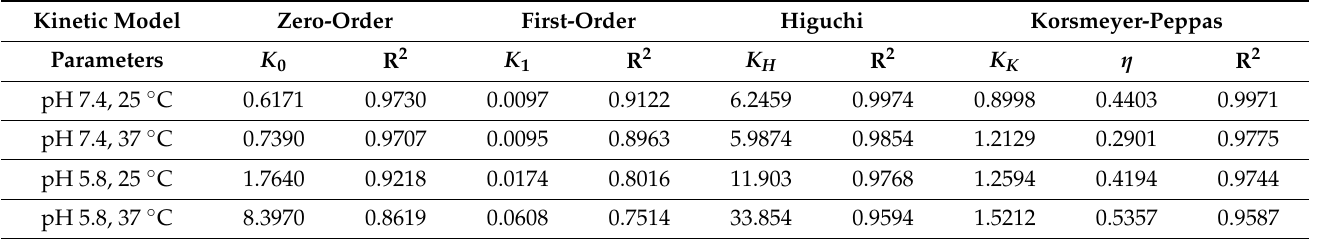
Table 2. In vitro release kinetic values of DOX from MNPsFe 3 O 4 -SiO 2 -poly(NVCL-co-MAA) 33% nanocomposite at different pH and temperature